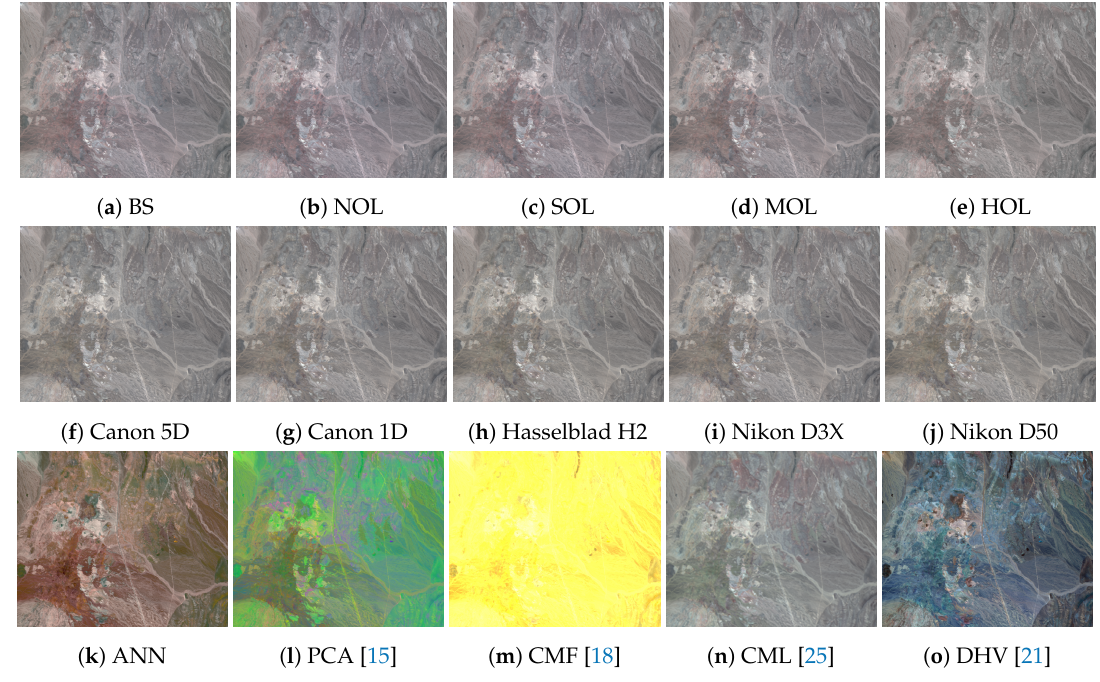
Figure 13. Experimental results on the Cuprite image. ( a ) BS. ( b ) NOL. ( c ) SOL. ( d ) MOL. ( e ) HOL. ( f ) Canon 5D. ( g ) Canon 1D. ( h ) Hasselblad H2. ( i ) Nikon D3X. ( j ) Nikon D50. ( k ) ANN. ( l ) PCA [15]. ( m ) CMF [18]. ( n ) CML [25]. ( o ) DHV